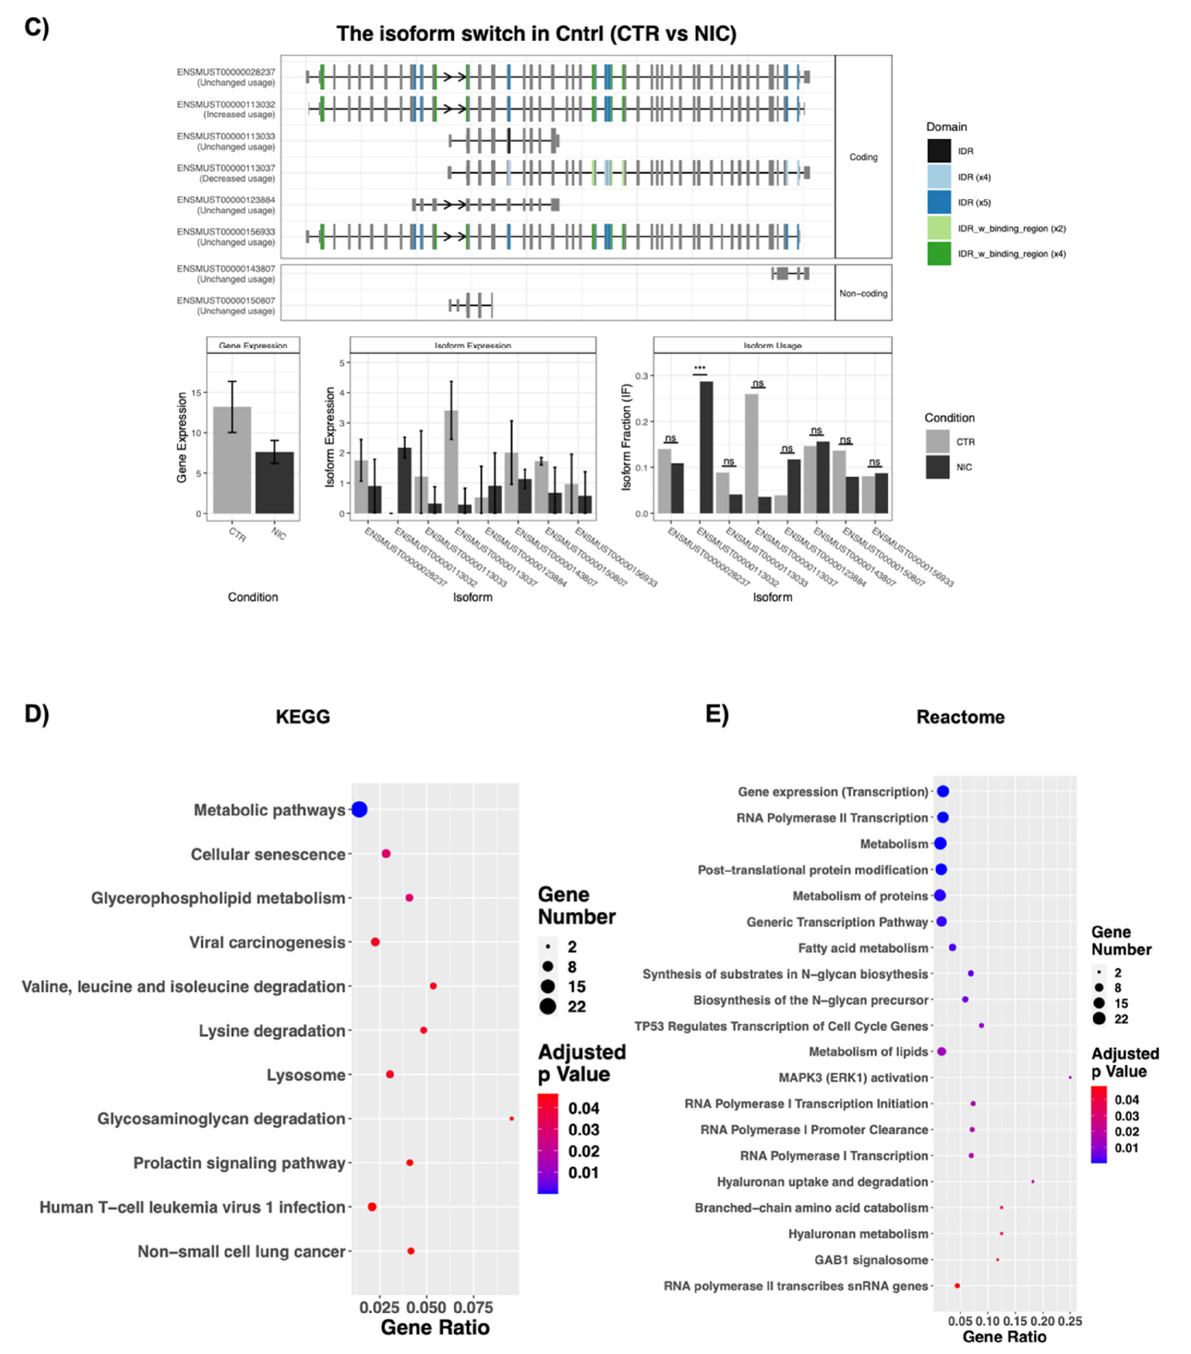
Figure 7. Genome-wide transcripts analysis for switched isoforms between Nichoid-expanded NPCs and standard floating conditions. ( A ) Illustration of alternative splicing event types for the switched isoforms and distribution of isoform usage (increased or decreased dIF) in each type. Created with BioRender.com. ( B ) Overview of the number of switched isoforms predicted to have functional consequences. ( C ) Visualization of switched isoform structure for Cntrl . KEGG ( D ) and Reactome ( E ) enrichment analysis for switched isoforms identified. The y -axis represents the name of the pathway, the x -axis represents the Rich factor, dot size represents the number of different genes, and the color indicates the adjusted p -value.